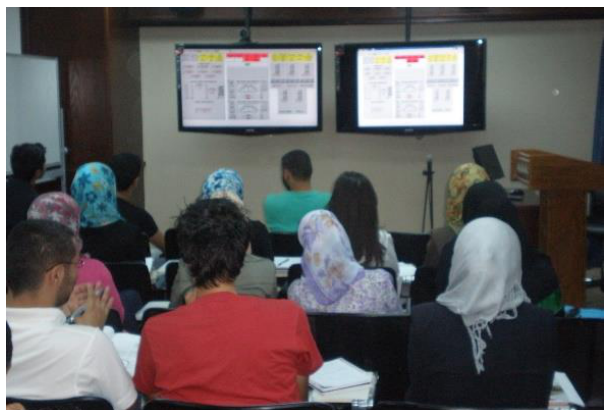
Fig. 3. Remote reactor laboratory session held on the campus of the Jordan University of Science and